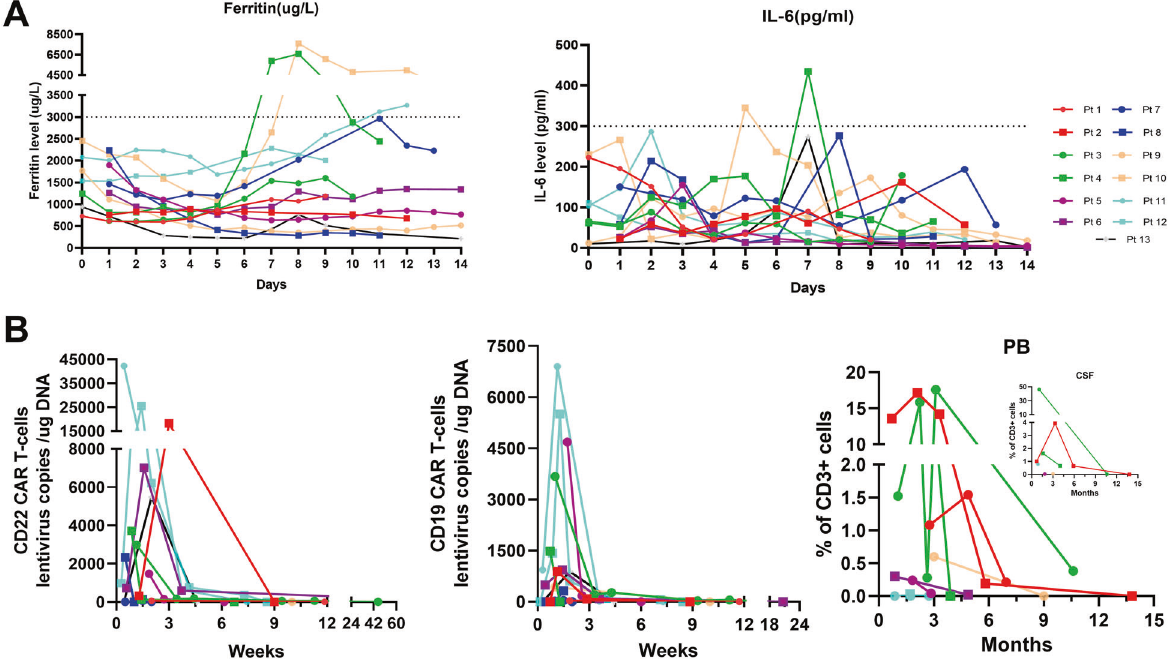
Fig. 3 The variation of in fl ammatory markers and CAR T-cell kinetics. A The serum ferritin and IL-6 level of patients. Increases in serum ferritin and IL-6 level were often accompanied by CRS and ICANS. B Lentivirus copies in vivo and percentage of CAR T-cells in CD3 + cells. The median peak number of CD19 and CD22 CAR T-cells lentivirus copies were 911 and 3346 copies/µg DNA, and the peak percentage of CAR T-cells in CD3 + cells in CSF and PB were 46.38% and 17.58%,